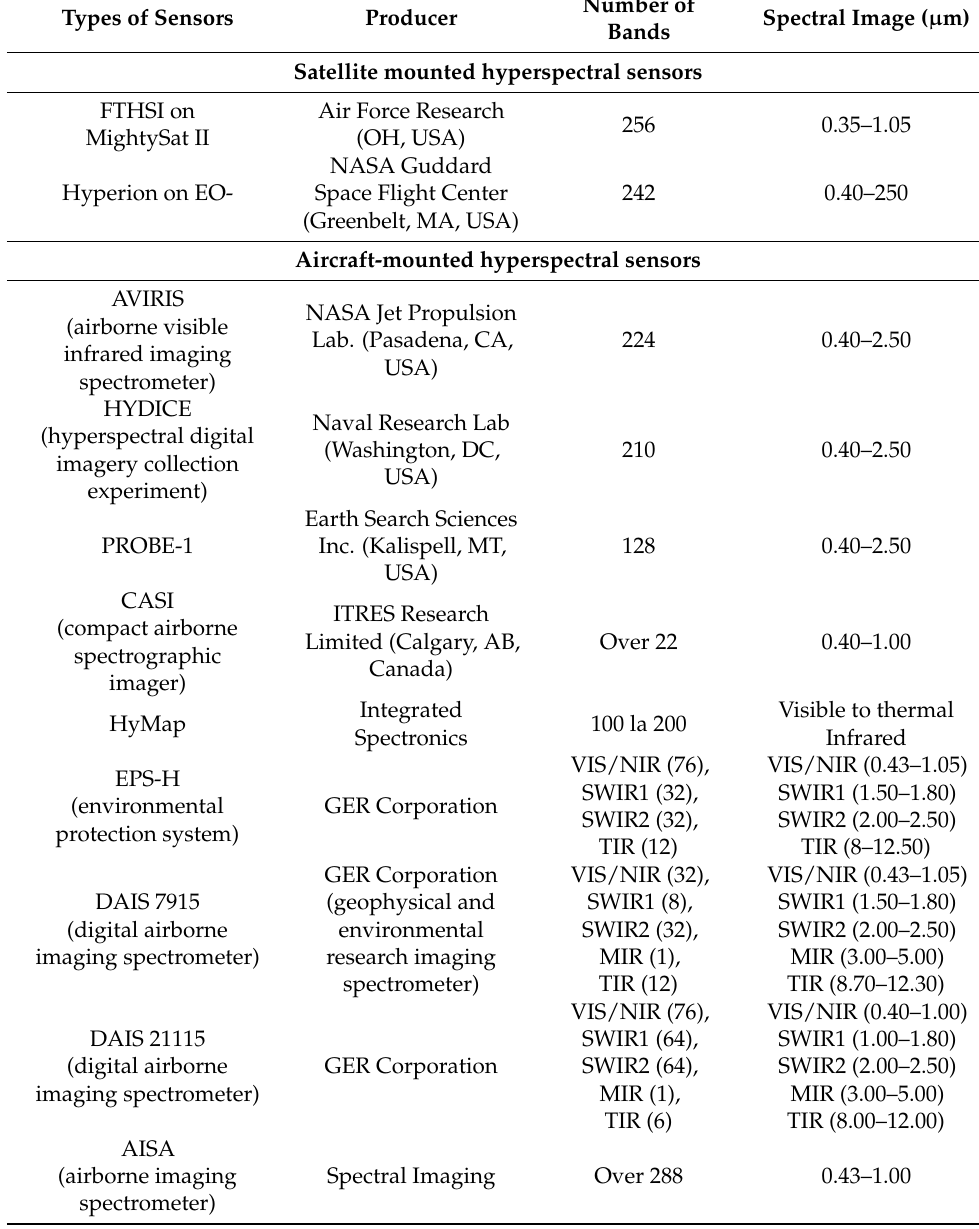
Table 4. Type of hyperspectral sensors on aircraft and satellites